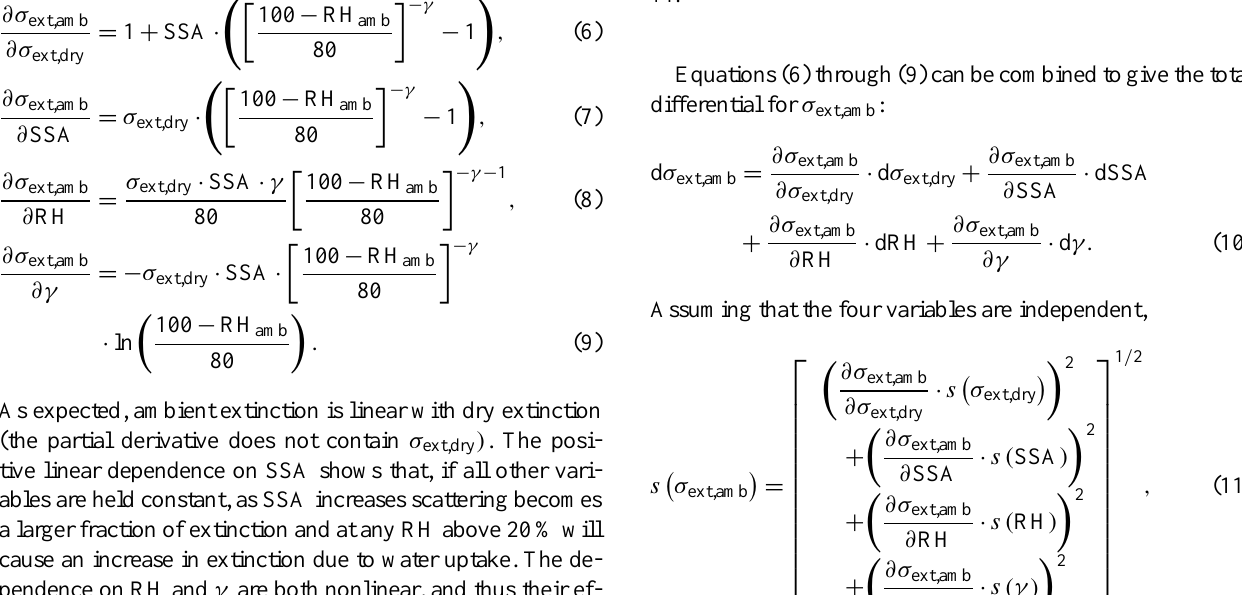
Figure 10. Average 532nm ambient extinction, dry extinction, and RH below 1km during spirals over the six sites during flights 1 and